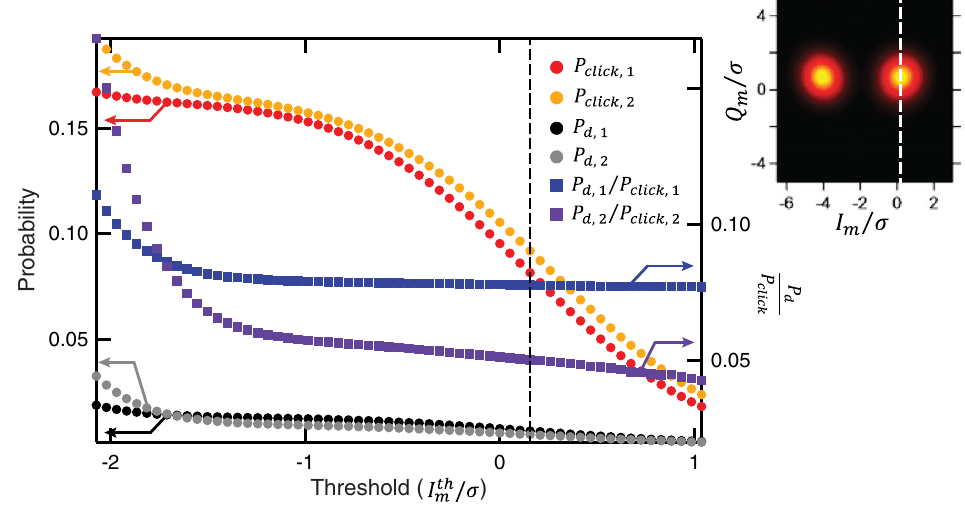
FIG. 11. Detector optimization. The probability of dark counts P axis) for each round of detection as a function of the readout threshold I th (inset), one for click and one for no click. By using a more stringent threshold for outcomes to be considered a click (black dashed line or white dashed line in inset), the ratio P